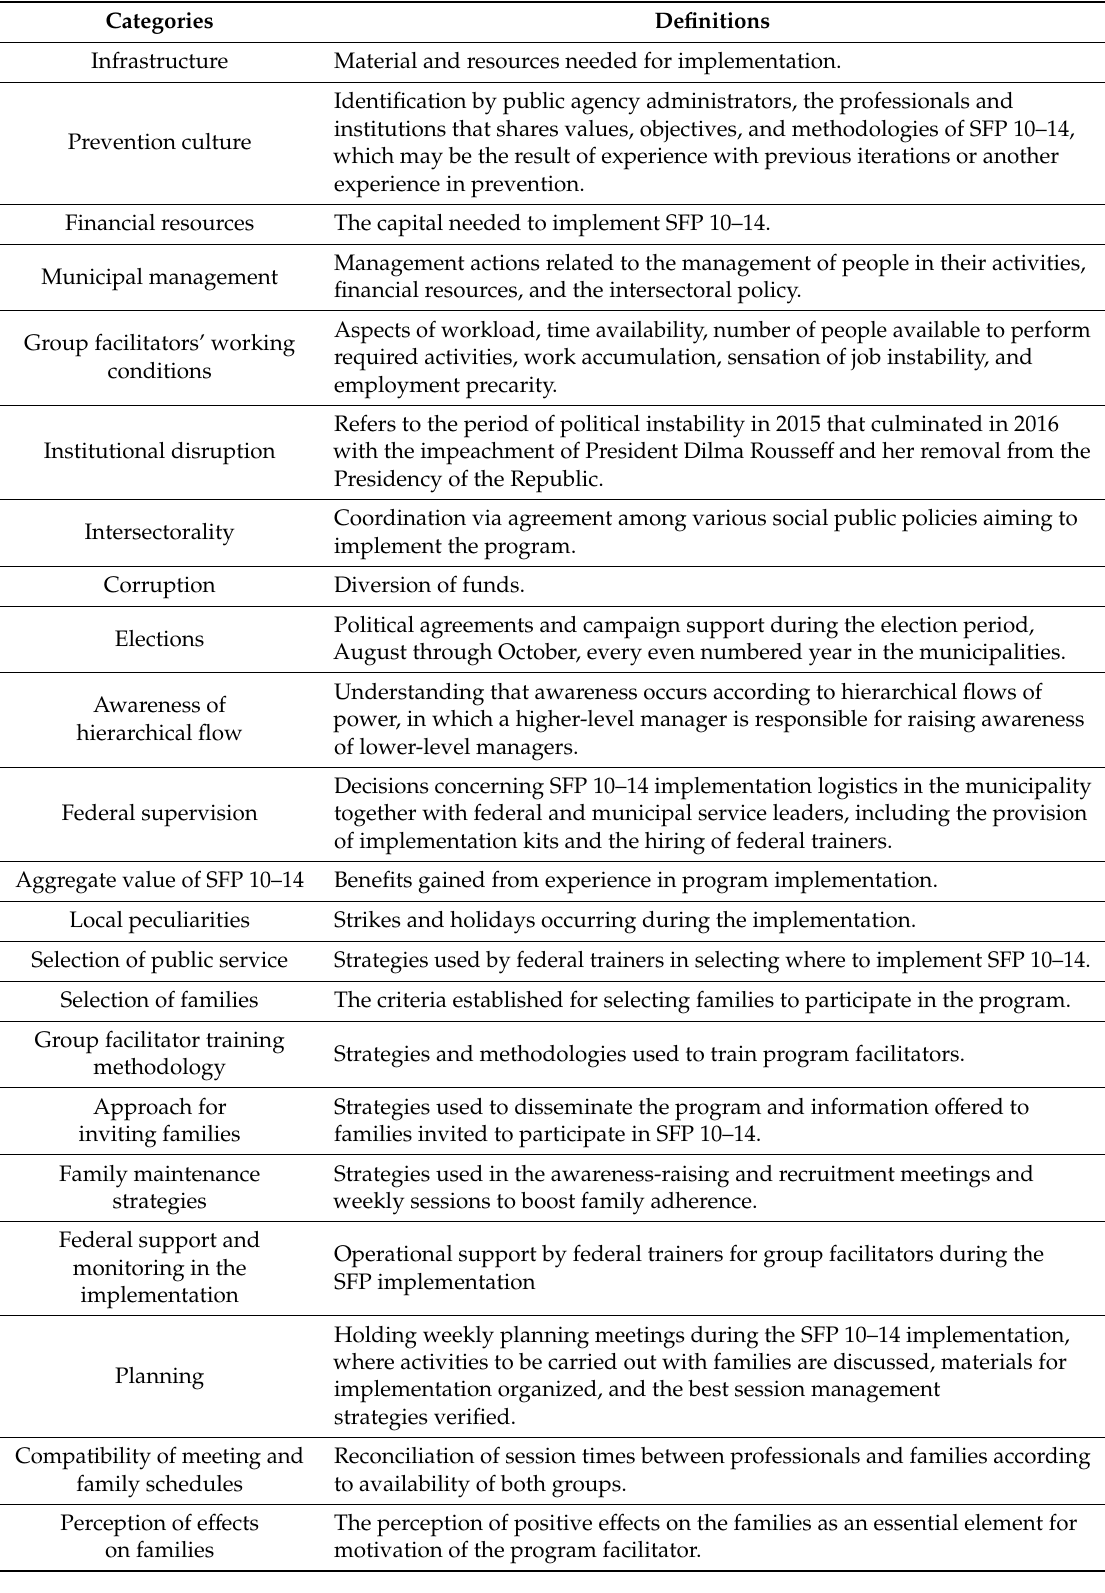
Table 2. Definitions of inductive analysis